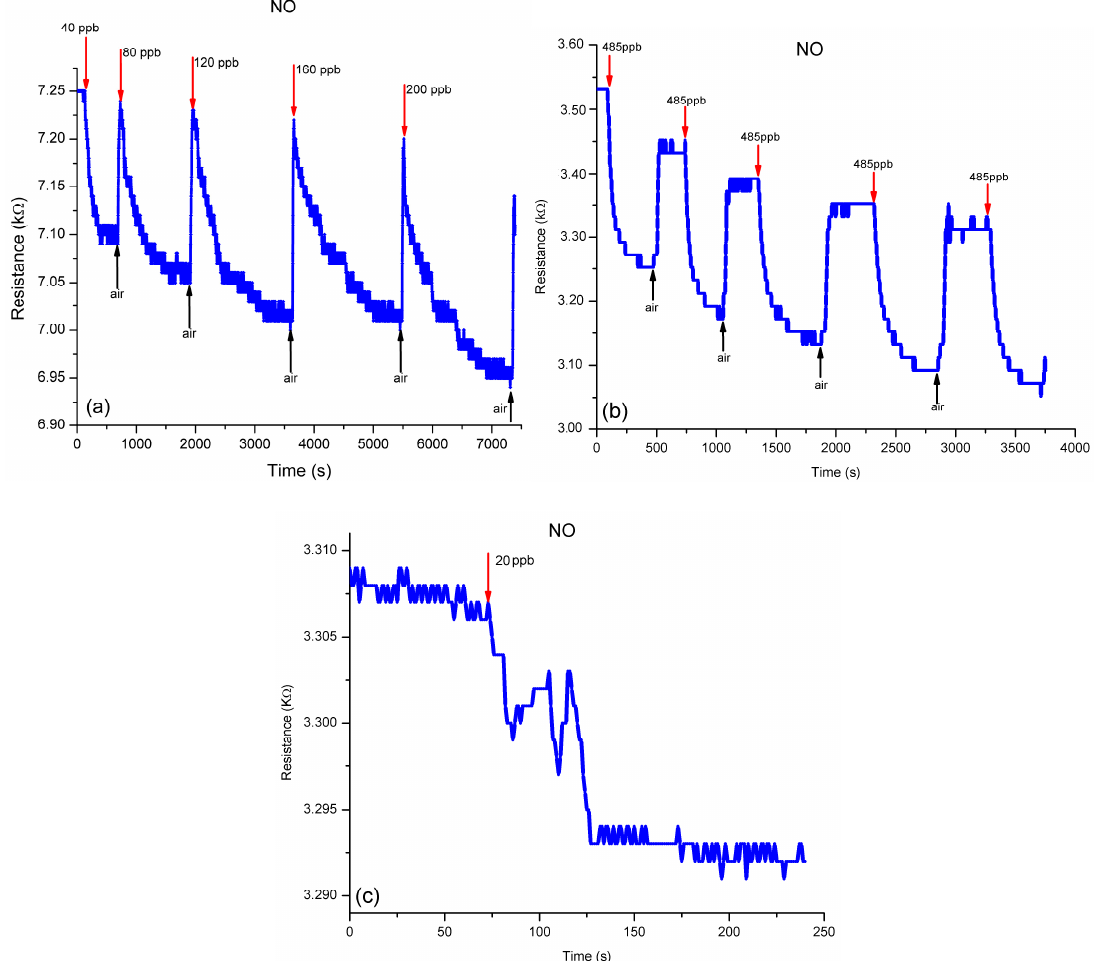
Figure 6. Sensing to different NO exposure: ( a ) sensor response toward variation of different NO in N 2 concentrations; ( b ) sensor repeatability to exposures at a concentration of 485 ppb NO in N 2 ; ( c ) sensor response on exposure at 20 ppb NO in N 2 .